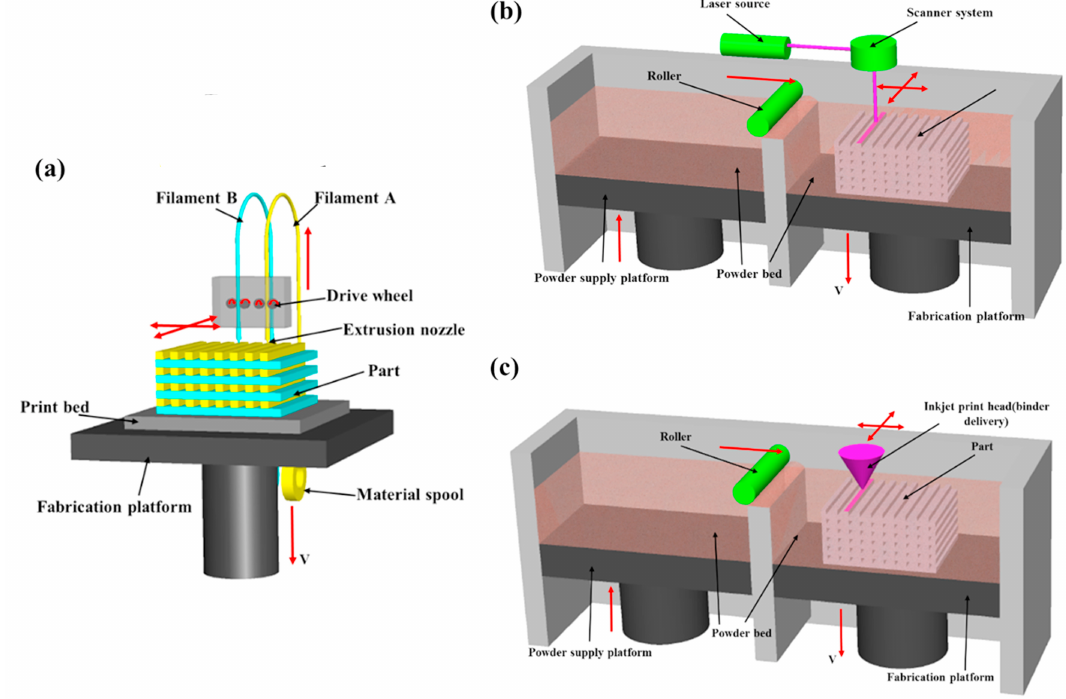
Figure 3. Comparison of the proposed schemes dor rapid prototyping. ( a ) Fused deposition modeling (FDM). ( b ) Selective laser sintering (SLS). ( c ) 3DP. Image adapted from Wang et al. [74] with permission of Elsevier